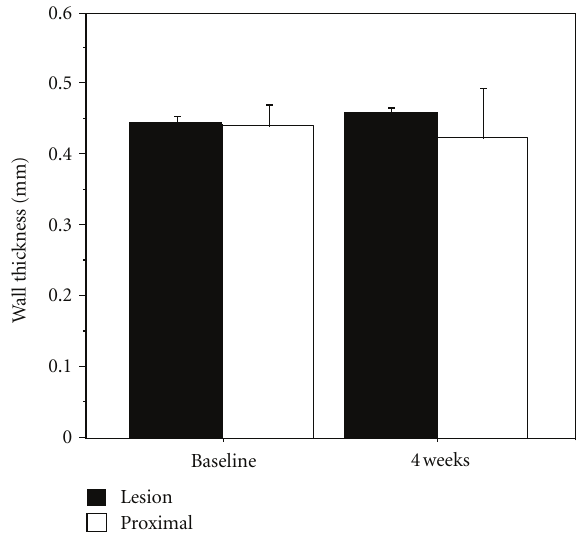
Figure 5: MRI-snakes-measured arterial wall thickness (mm) in lesion and proximal segment at baseline and 4 weeks. Mean values calculated from 6 slices for each of the 6 animals, 36 slices from PTA-treated region, and 36 slices from non-a ff ected region.